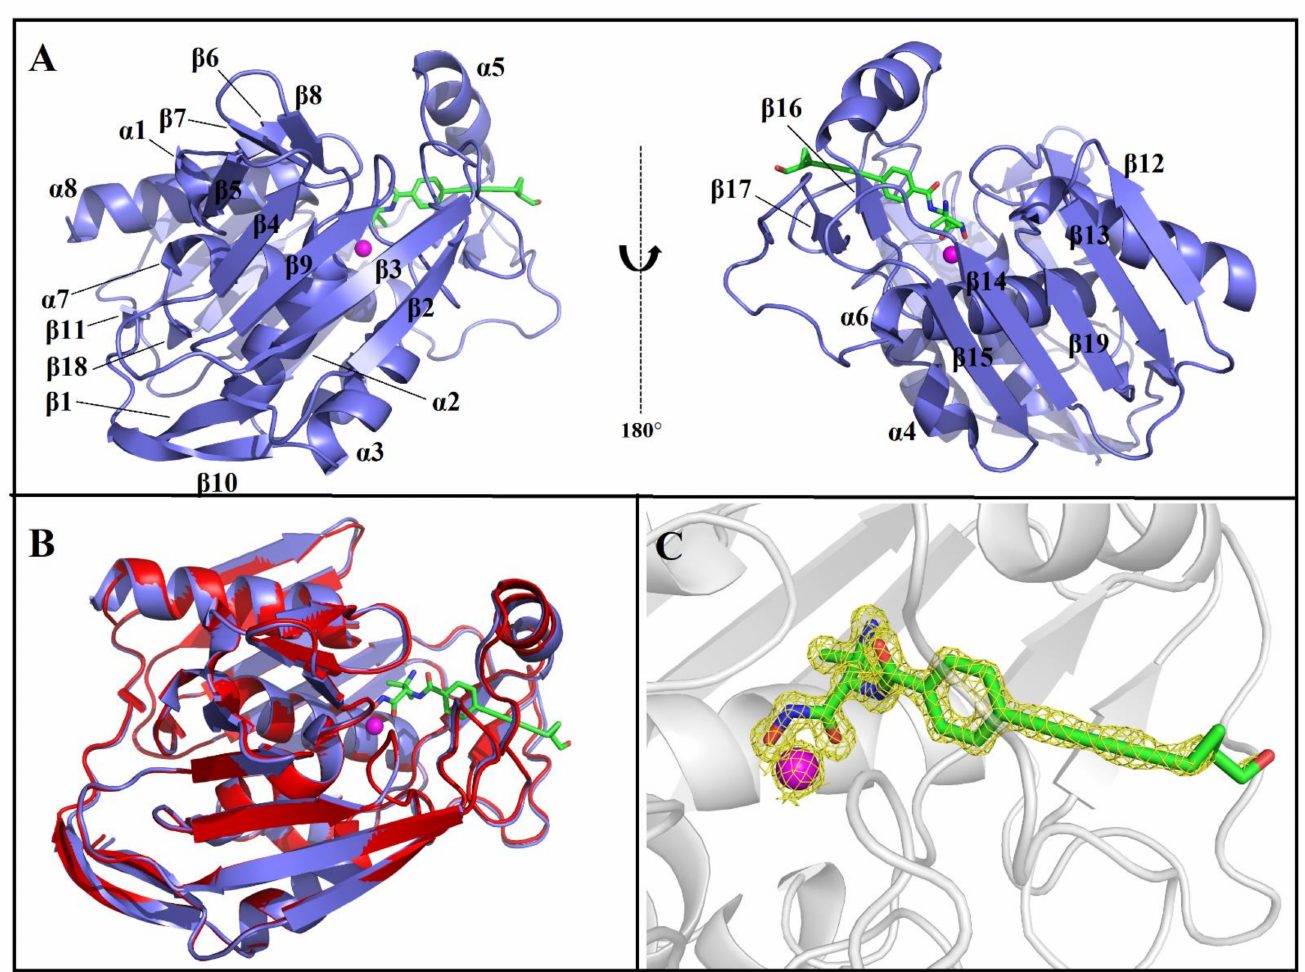
Figure 2. The crystal structure of AaLpxC in complex with ACHN-975. ( A ) Overall structure of LpxC from A. aeolicus . The 8 α -helices and 19 β -sheets represent α 1– α 8 and β 1– β 19, respectively. ( B ) Superimposition of the overall structures of monomeric AaLpxC in the apo form (red, PDB: 1P42) and AaLpxC · ACHN-975 (slate). ( C ) 2Fo–Fc map showing the ACHN-975 and Zn 2+ calculated at 2.0 σ . The ACHN-975 molecule is shown as sticks. The Zn 2+ -ion is depicted as magenta